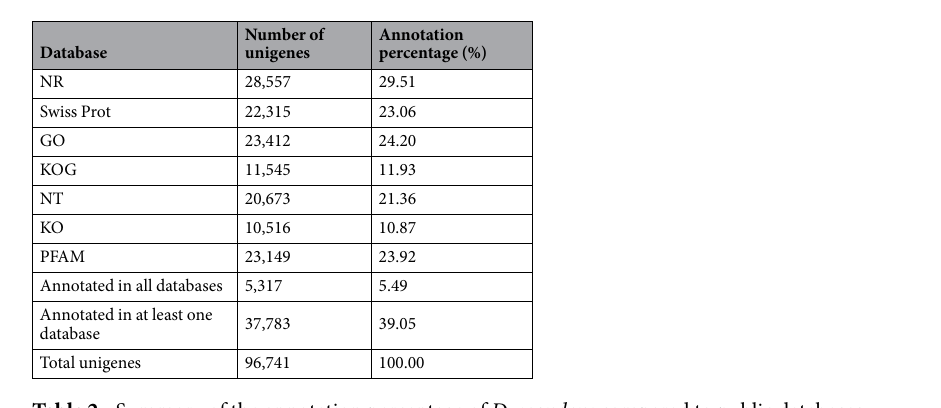
Table 2. Summary of the annotation percentage of D . scandens compared to public